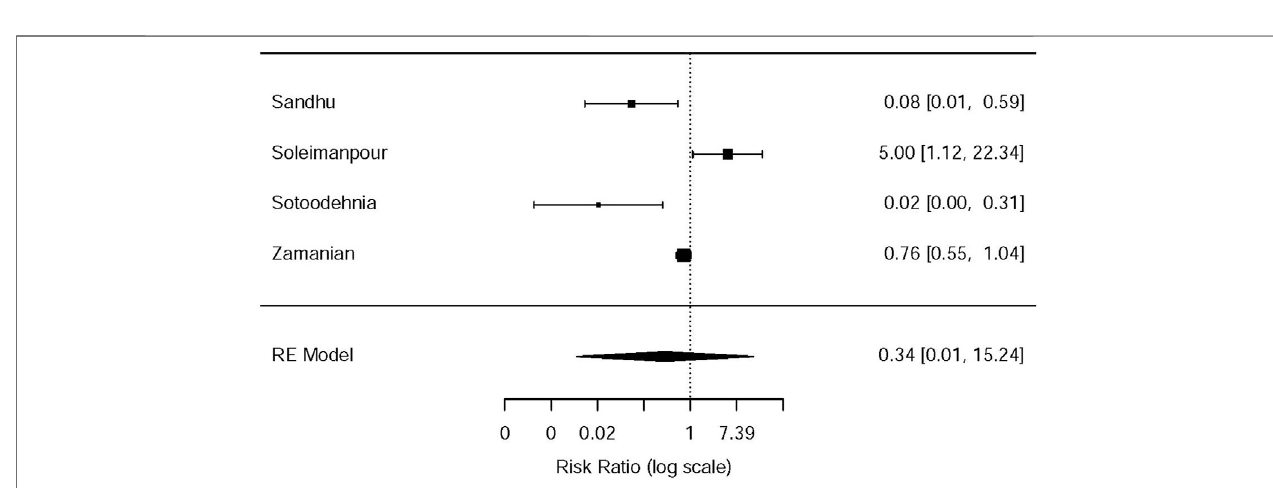
FIGURE 9 | The results of meta-analysis for dizziness caused by the medications.